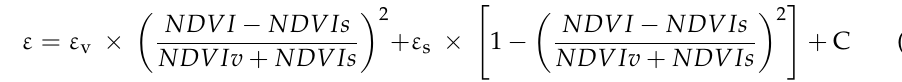
Table 1. Standard values of emissivities used in the LST analysis (Jeevalakshmi et al., 2017). NDVI Range Emissivity Value ( ε ) Land-Cover Type NDVI ≤ 0 0.991 Water 0 < NDVI < 0.2 0.966 Soil 0.2 ≤ NDVI ≤ 0.5 Applied Equation (2) Mixture of soil and vegetation cover NDVI > 0.5 0.973 Natural vegetation (forest or